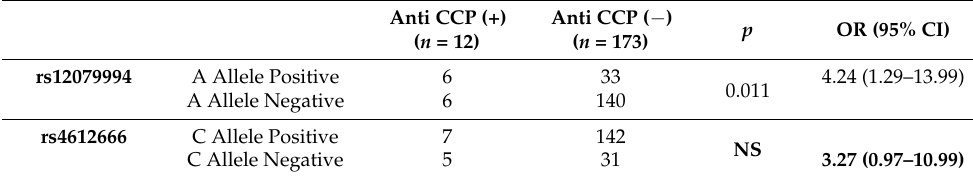
Figure 2. Anti-CCP antibody titer in rs10754558 C/G polymorphisms in RA patients. Table 4. Associations of alleles of NLRP3 genotype with anti-CCP antibody in primary Sjogren’s syndrome